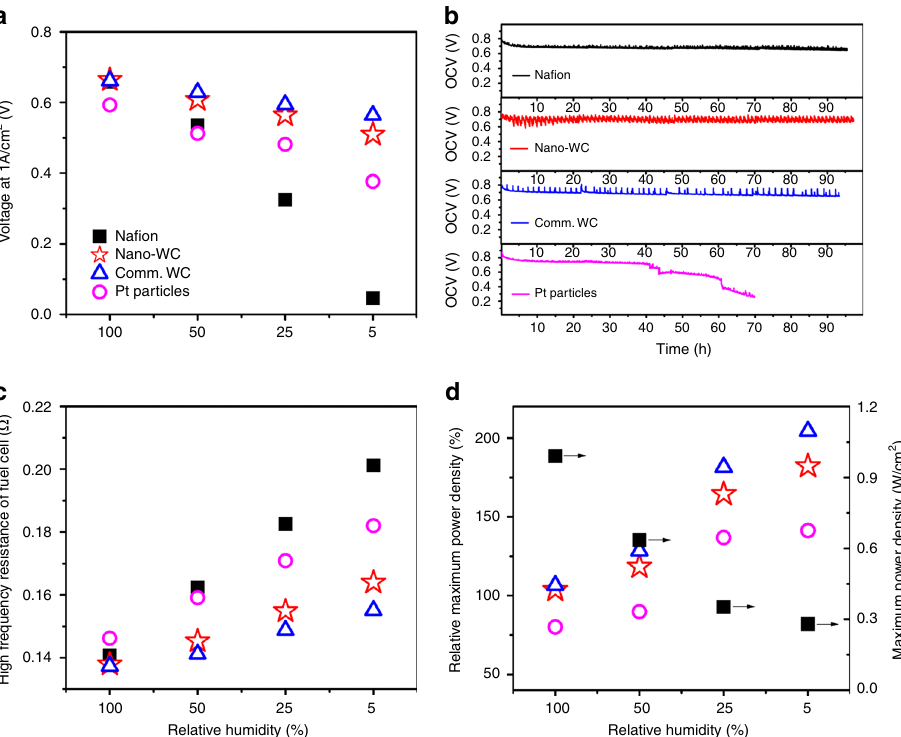
Fig. 3 Fuel cells performance of recast Na fi on and composite membranes. a Fuel cell performance at 1 A/cm 2 condition under 5, 25, 50, and 100% relative humidity. b Proton conductivity of the fuel cell with recast Na fi on membrane MEA and composite membranes MEAs measured by two-probe electrochemical impedance spectroscopy. c 100 h accelerated fuel cell durability tests. d Relative maximum power density ( P c / P N × 100, where P c and P N are the maximum power densities of the composite membranes and pristine Na fi on membrane, respectively) measured at different relative humidity. Closed squares represent the pristine Na fi on membrane, open circles , stars , and triangles represent the composite membranes with 5wt. % commercial WC, nano-WC, and Pt,